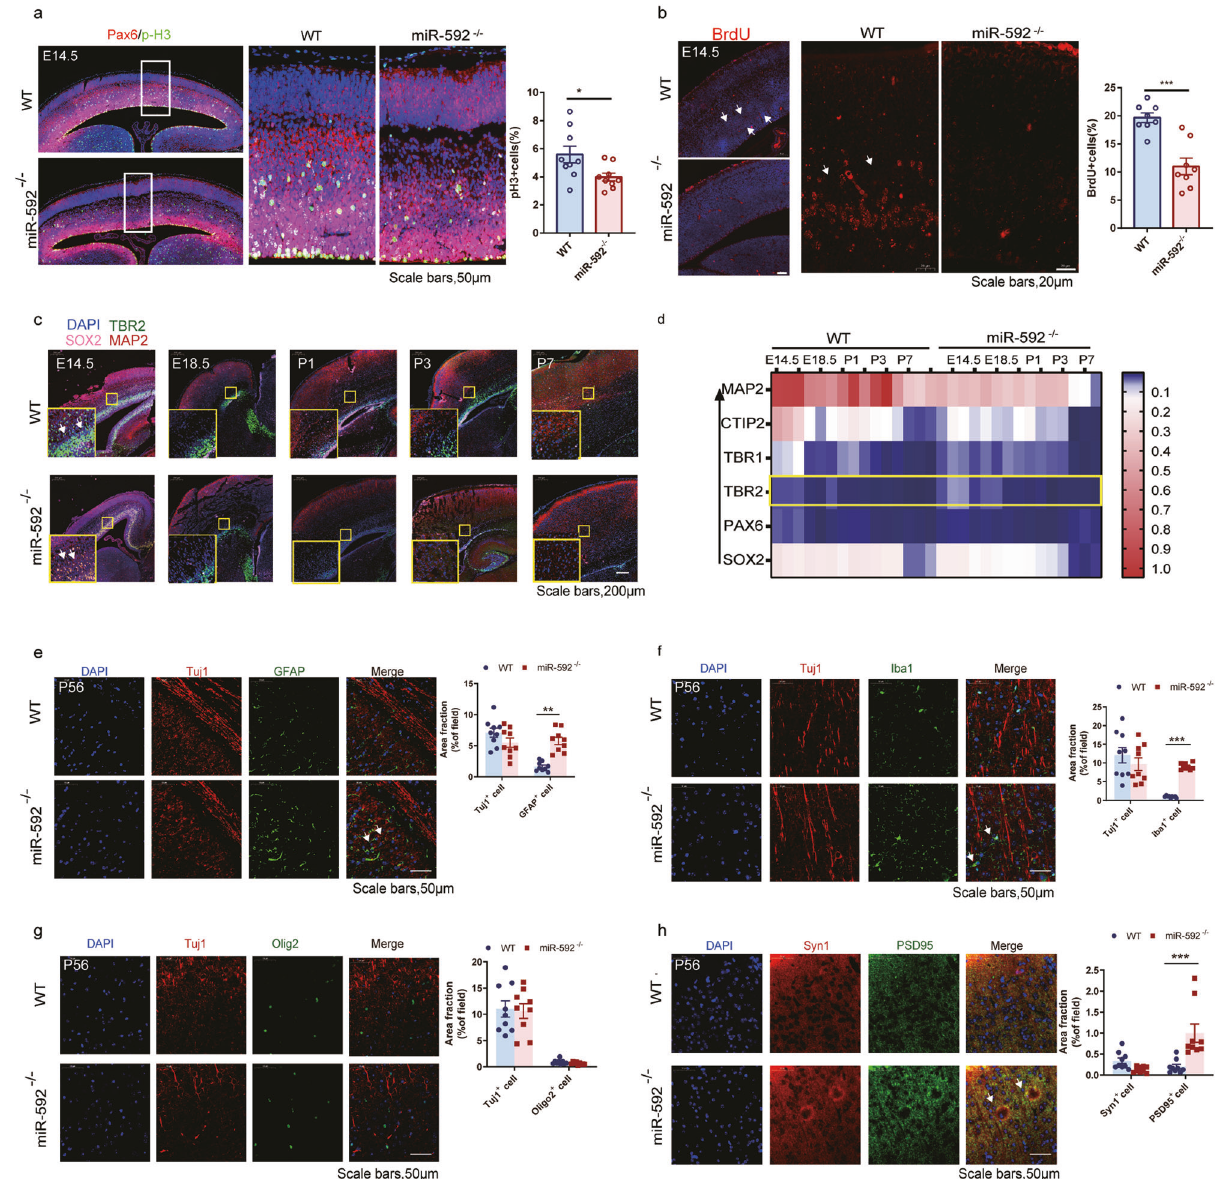
Fig. 2 miR-592 deletion impairs cortical neurogenesis and adult lineage choice. a Double immuno fl uorescence staining. Pax6 staining (red immuno fl uorescence), p-H3 staining (green immuno fl uorescence), and DAPI staining (blue fl uorescence). Unpaired two-tailed t test. Error bars represent S.E.M. Experiments were carried out using three biological replicates. Each sample was observed in three fi elds of view. b BrdU staining (red immuno fl uorescence) and DAPI staining (blue fl uorescence). Unpaired two-tailed t test. Error bars represent S.E.M. Experiments were carried out using three biological replicates. Each sample was observed in three fi elds of view. c E14.5 – P7 sagittal sections were immunostained for the radial glial marker SOX2 (pink), the IPCs marker TBR2 (green), and the neuronal marker MAP2 (red). Nuclei were labelled with DAPI. d E14.5 – P7 RT-PCR showed that TBR2 + cells were dysregulated in the SVZ in miR-592 − / − mice beginning at E14.5. VZ/SVZ ventricular/subventricular zone (PAX6 and SOX2), IZ the intermediate zone (TBR2), CP cortical plate (TBR1 and CITP2), MZ marginal zone (MAP2). e – h Double immuno fl uorescence staining. e Tuj1 staining (red immuno fl uorescence), GFAP staining (green immuno fl uorescence), and DAPI staining (blue fl uorescence). f Tuj1 staining (red immuno fl uorescence), Iba1 staining (green immuno fl uorescence), and DAPI staining (blue fl uorescence). g Tuj1 staining (red immuno fl uorescence), Olig2 staining (green immuno fl uorescence), and DAPI staining (blue fl uorescence). h Syn1 staining (red immuno fl uorescence), PSD95 staining (green immuno fl uorescence), and DAPI staining (blue fl uorescence). All data were analysed by two-way ANOVA followed by Tukeys multiple comparison test. Error bars represent S.E.M. * p < 0.05, ** p < 0.01, *** p < 0.001. The averages of nine different fi elds of view were calculated for each animal (counts from three fi elds of three sagittal [30]. In ISH, miR-592 was detected mainly in the cell bodies of the mouse neurons of the cortex (Fig. 1a). Accordingly, the expression ventricular zone (VZ) and subventricular zone (SVZ) at E12.5 and patterns of miR-592 in WT mice were detected by RT-PCR. The E14.5, while E16.5 to P7, miR-592 was detected most abundant in expression of miR-592 increased from E12.5 to E14.5, reached a the intermediate zone (IZ) and cortical plate (CP). miR-592 levels peak at E16.5, then decreased to a low level around P1 and were declined precipitously after P14 (Fig. 1c and Fig. S1a). Given persisted through adulthood (Fig. 1b). The peak suggests that this, miR-592 knockout mouse line was generated by CRISPR/Cas9 miR-592 plays an essential role in the early neurogenesis of mice